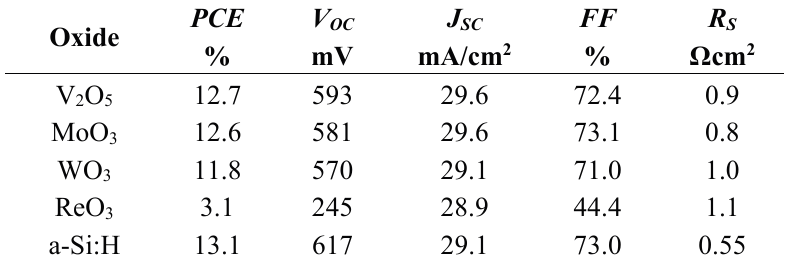
Table 2. Performance parameters of the fabricated oxide/n-Si solar cells and the a-Si:H reference device.